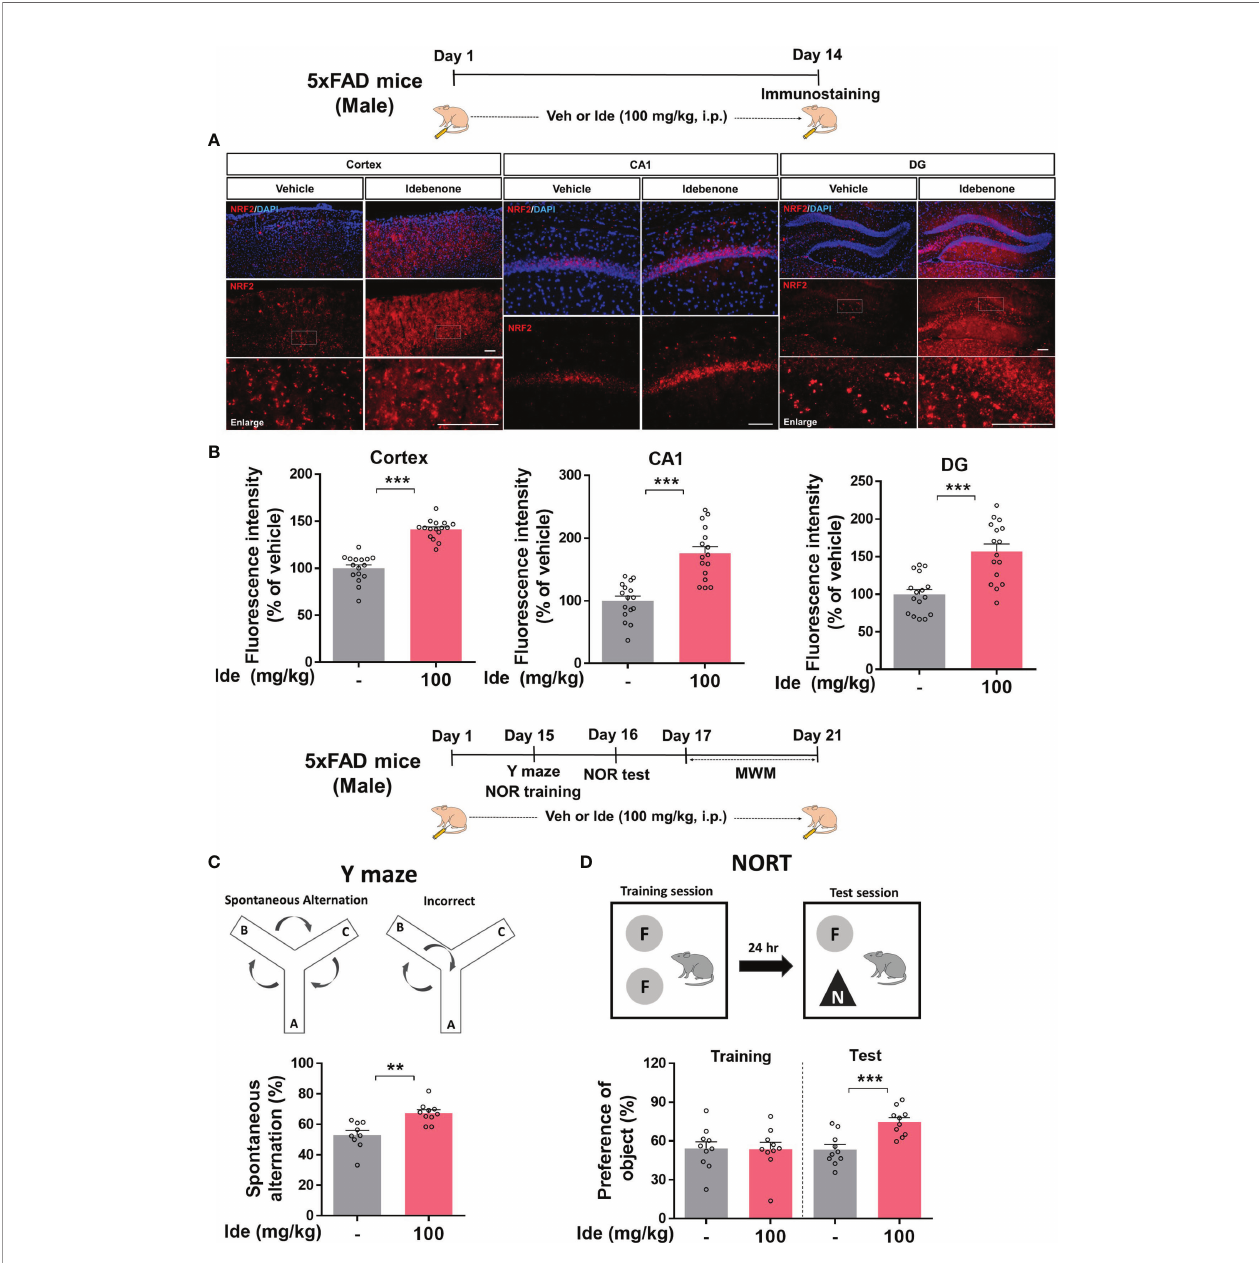
FIGURE 9 | Idebenone increases levels of the neuroprotective marker NRF2 and ameliorates A b -mediated cognitive dysfunction in 5xFAD mice. (A) Three-month- old 5xFAD mice were administered idebenone (100 mg/kg, i.p.) or vehicle (5% DMSO + 10% PEG + 20% Tween80) daily for two weeks. Then, immuno fl uorescence staining with an anti-NRF2 antibody or behavioral tests were performed. (B) Quanti fi cation of NRF2 immuno fl uorescence intensity (n = 16 brain slices from 4 mice/ group). (C) Y maze diagram and quanti fi cation of spontaneous alternation (n = 9-10/group). (D) NOR test diagram and quanti fi cation of object preference (n = 9-10/ group). **p < 0.01 and ***p < 0.001. Scale bar = 100 m